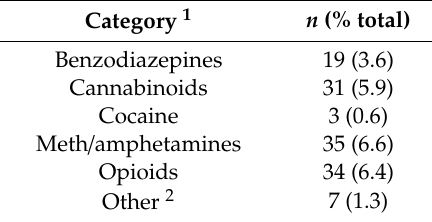
Table A2. Categories of illicit drug use.